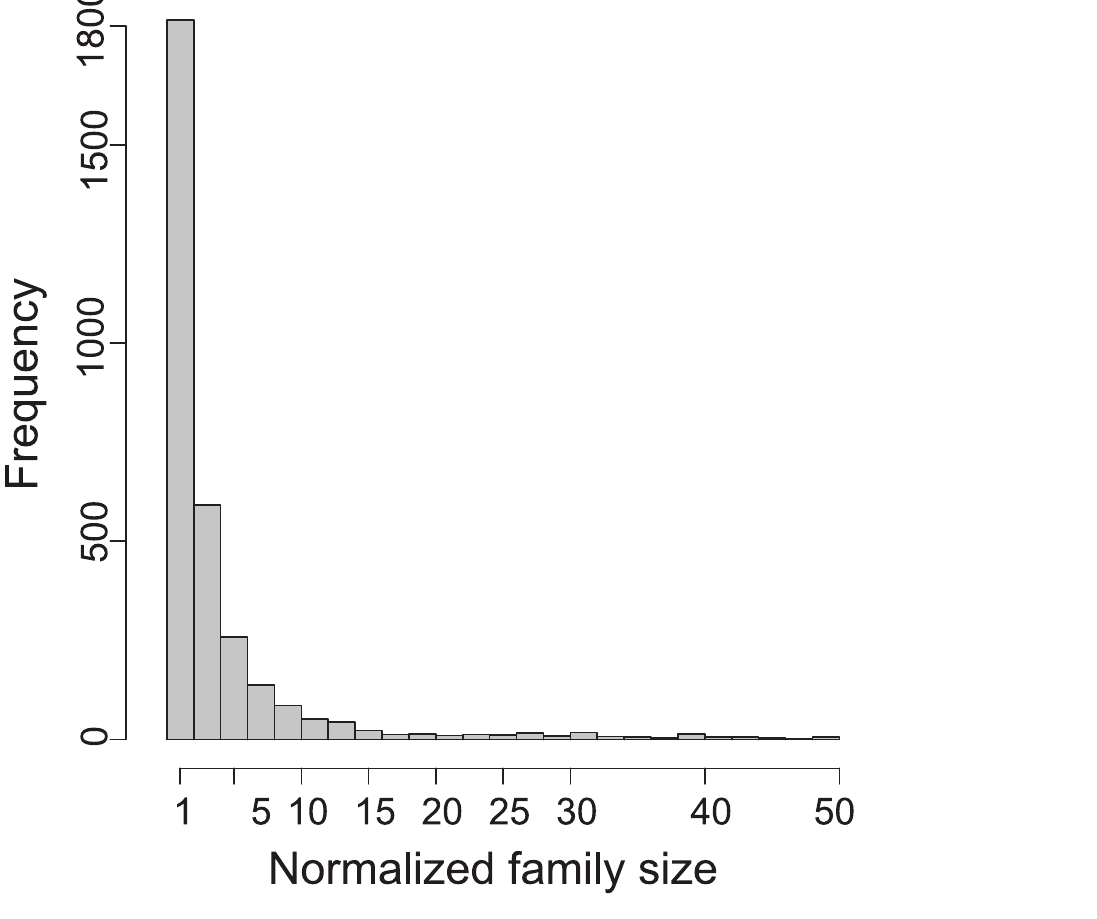
Figure 1. Histogram of the normalized size of gene families. For each family we compute the number of genes in the family and subtract it by the number of genomes containing at least one member of the family.